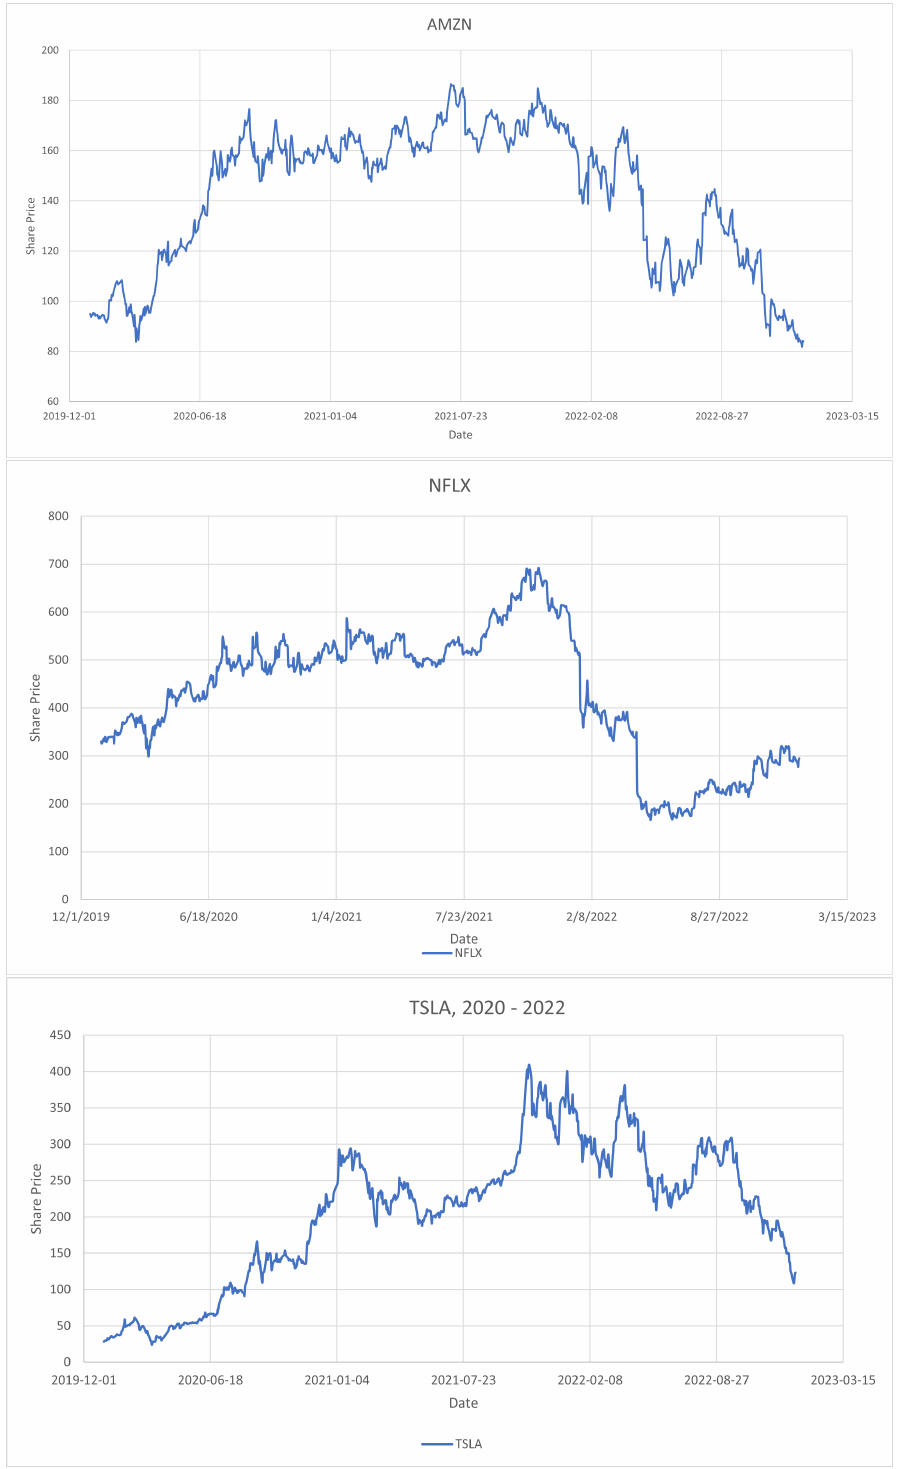
Figure 5. If the major indices SPX and IXIC had a rough ride during 2020–2022, just look at some popular stocks: ( top ) AMZN, ( middle ) NFLX, and ( bottom )